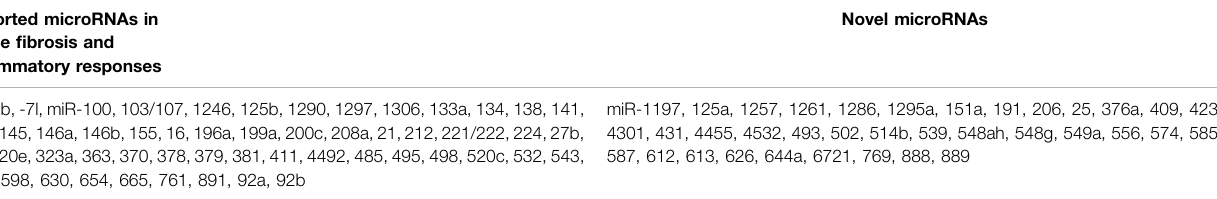
( Table 1 ) and fi led in WIPO (PCT) WO2019169380A1 (Stem cell-derived exosomes for treatment of corneal scarring. 2019.